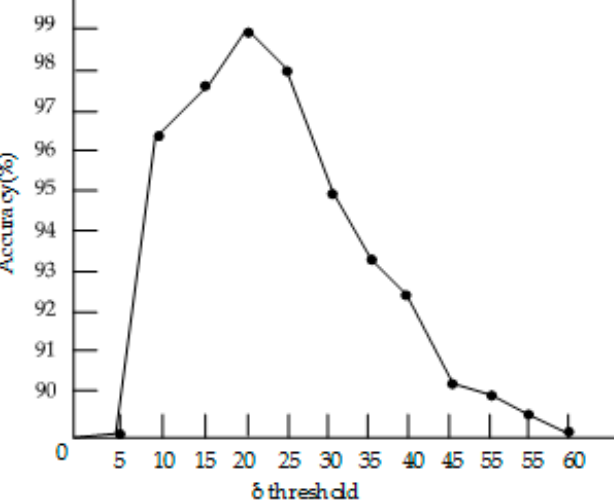
Figure 14. Setting of the constraint threshold δ .